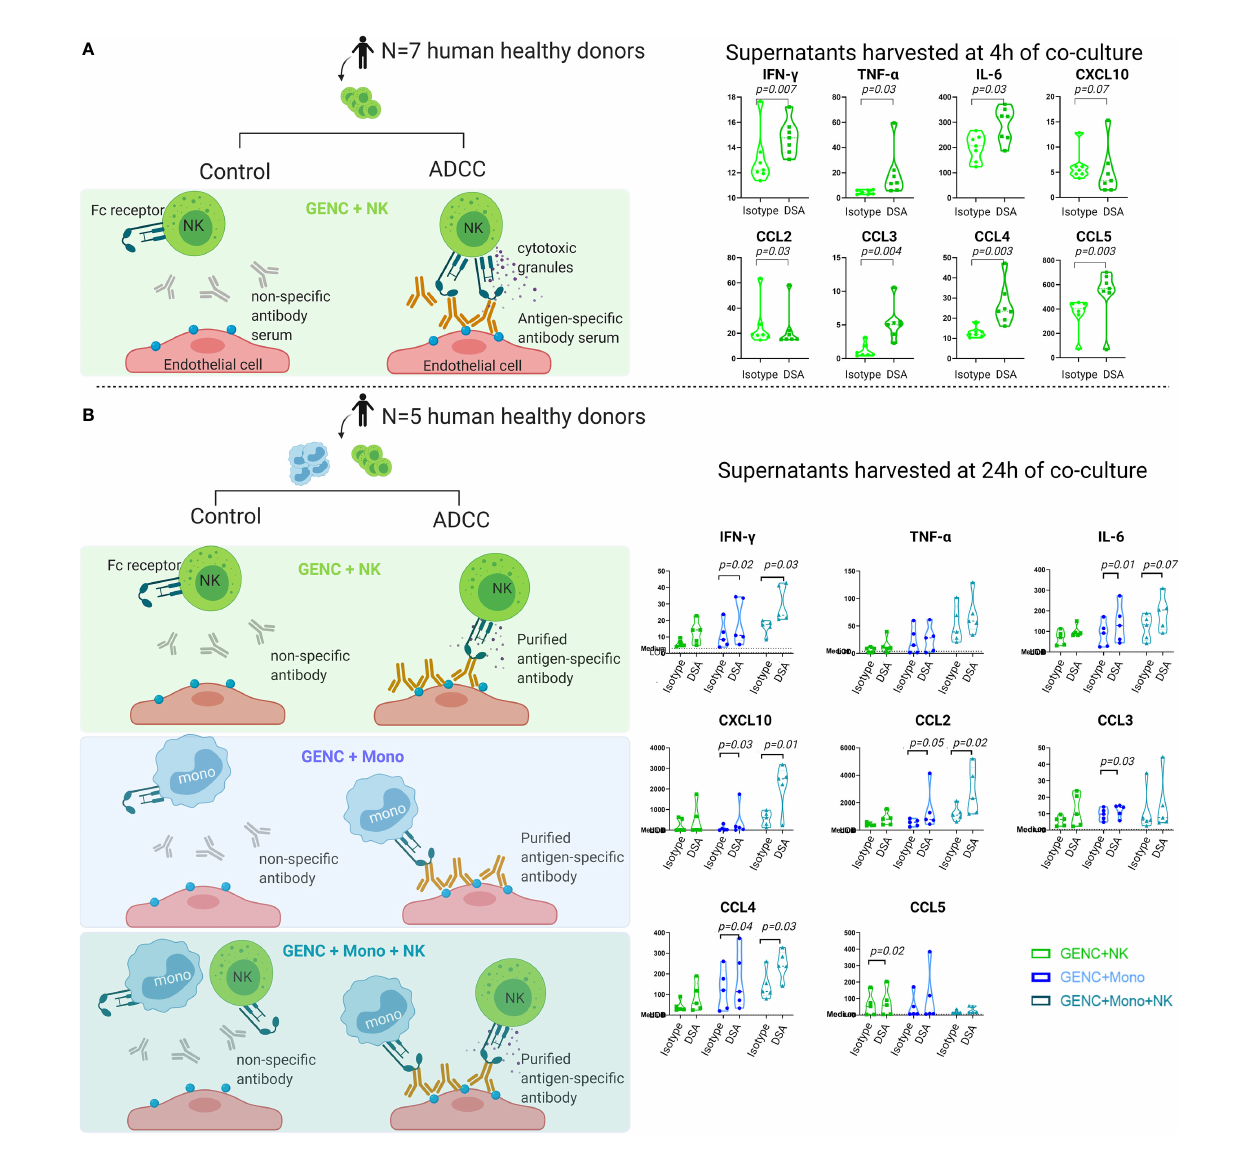
FIGURE 5 | Cytokine pro fi les in supernatants of NK cells and/or monocytes cocultured with HLA class I antibody-activated glomerular endothelial cells or isotype antibodies. (A) NK cell experiment using NK cells from 7 human donors, cocultured with human antibody serum (anti-HLA-A2-containing serum or control pooled serum that was negative for anti-HLA A2) and ciGENC (immortalized glomerular endothelial cells), harvested after 4 h. (B) NK cell and monocyte experiment using NK cells and CD16+ monocytes from 5 human donors, cocultured with murine antibody (anti-HLA-A, -B, -C, or control isotype) and GENC (primary glomerular endothelial cells, Cell Systems, USA); harvesting of supernatants was done after 24 h of coculture. Violin plots of the cytokine concentrations (pg/mL) of the signi fi cantly differently expressed cytokines in both conditions, as assessed by a paired parametric T-test of the log10 transformed